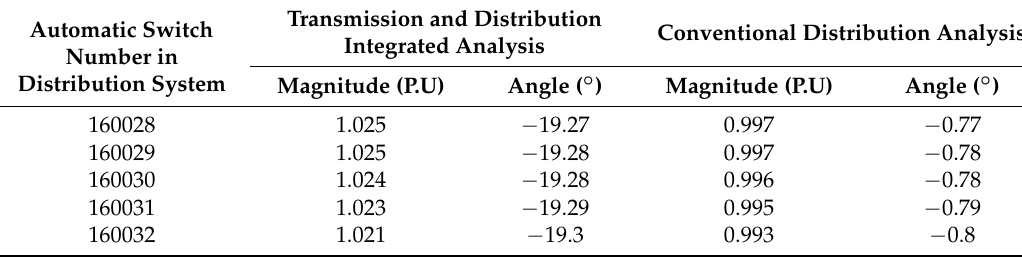
Table 2. Comparison between conventional distribution analysis and integrated